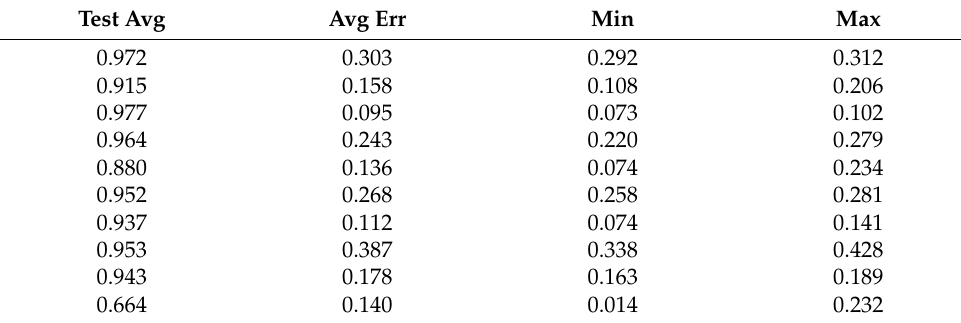
Table A179. Set 3, trials 11–20 data (average actual PR values).